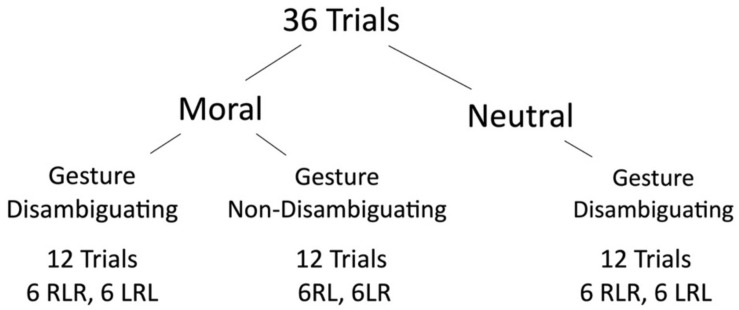
Experimental design.